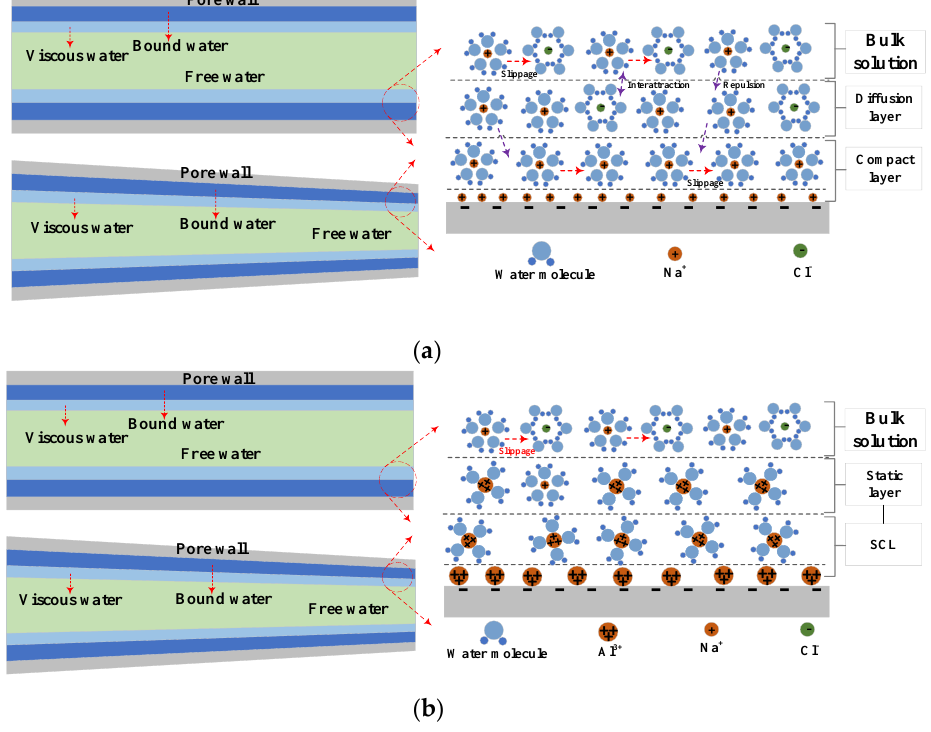
Figure 1. Pore-scale migration model. ( a ). Transport of water and chloride ions under weak correlation. ( b ). Transport of water and chloride ions under strong correlation. The length of the model is set as 100 nm, the basic aperture is set as 10 nm, wedge coefficient is set as 1.0. The left and right boundaries of the model are the inlet and outlet of fluid transport, respectively, and the chloride concentration at the inlet is 0.44 mol/L, which is close to the upper limit of chloride concentration of pore solution in cement-based materials. The initial thickness of EDL is 2.038 nm, the thickness of the compact layer is 1.068 nm and the thickness of the diffusion layer is 0.97 nm. The time-varying velocity of diffusion layer is determined by the Poisson-Boltzmann equation and the Einstein-Stokes equation, the time-varying process of the electric double layer is simulated by the dynamic grid module in COMSOL Multiphysics. More detailed information about the governing equations and boundary conditions can be obtained from our previous